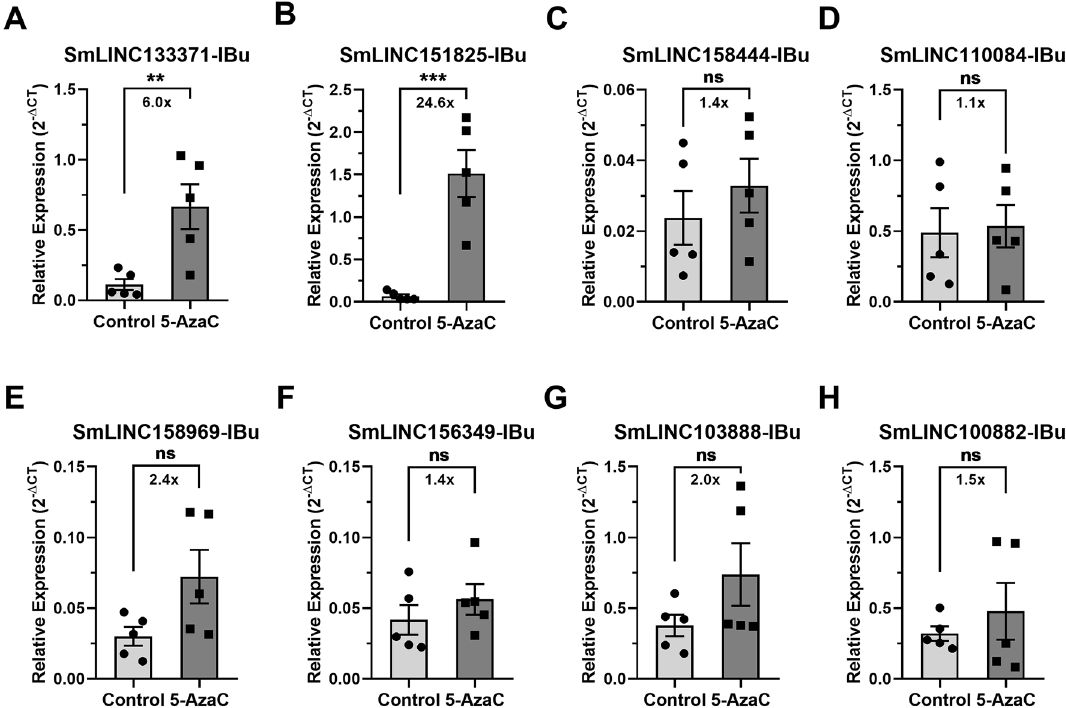
Figure 5. Expression profiles in S. mansoni males of selected lincRNAs differentially expressed after 5-AzaC treatment (491 µM). Eight lincRNAs were selected after re-analysis of RNA-Seq public datasets of 5-AzaC treated S. mansoni females 16 for evaluation of differential expression by RT-qPCR in S. mansoni males. For each of the eight lincRNAs, the expression profiles in controls and in 5-AzaC treated S. mansoni males by RT-qPCR are shown: ( A ) SmLINC133371-IBu; ( B ) SmLINC151825-IBu; ( C ) SmLINC158444-IBu; ( D ) SmLINC110084- IBu; ( E ) SmLINC158969-IBu; ( F ) SmLINC156349-IBu; ( G ) SmLINC103888-IBu; ( H ) SmLINC100882-IBu. Mean ± SEM from five biological replicates are shown, and Student unpaired two-sided t test was applied; **p < 0.01, ***p < 0.001; ns not